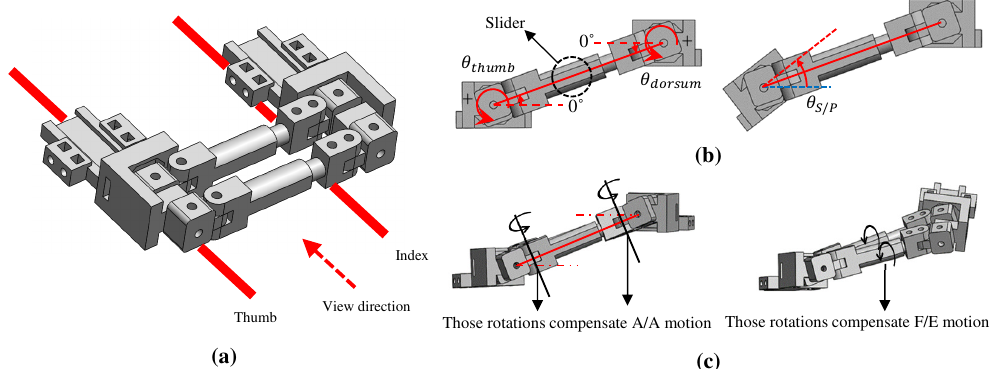
Figure 8. Calculation of S/P angle; ( a ) Initial position; ( b ) S/P motion when F/E and Ab/Ad motions do not occur; ( c ) Structure movement when F/E and Ab/Ad